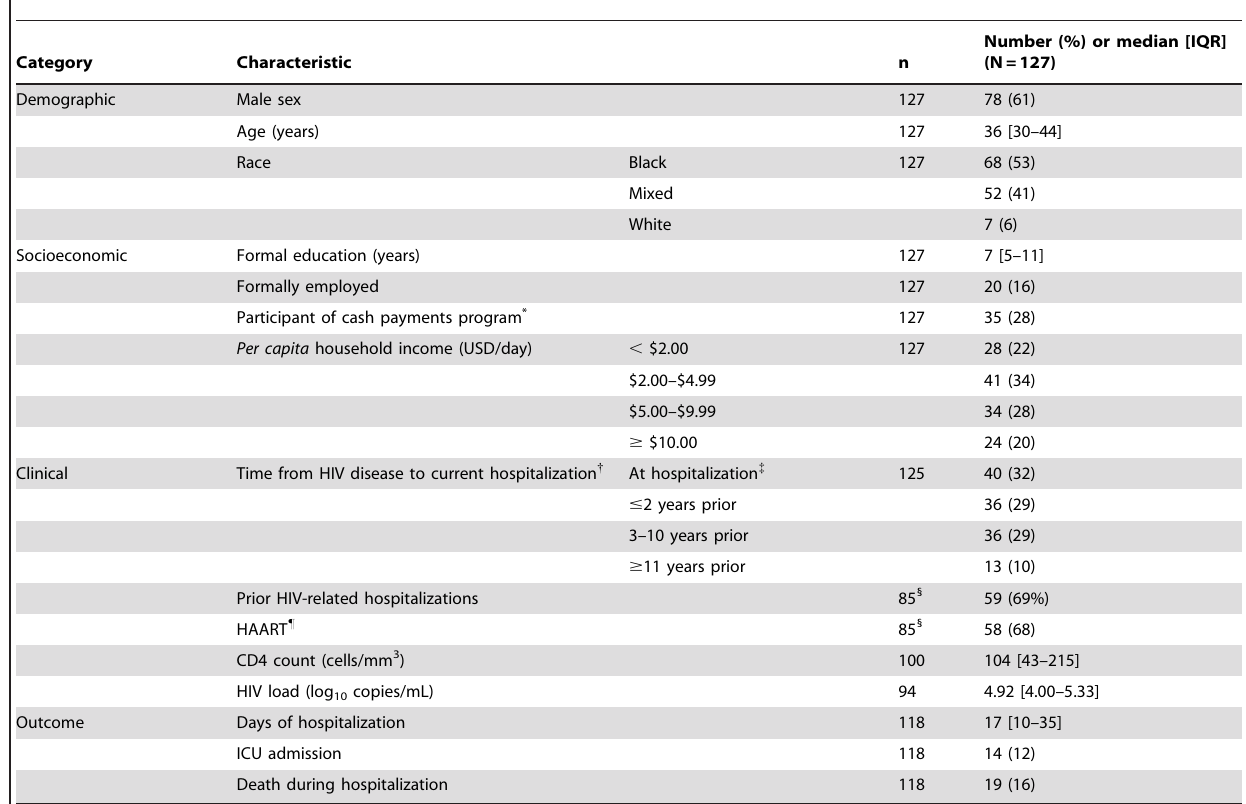
Table 1. Sociodemographic and clinical characteristics of patients hospitalized with